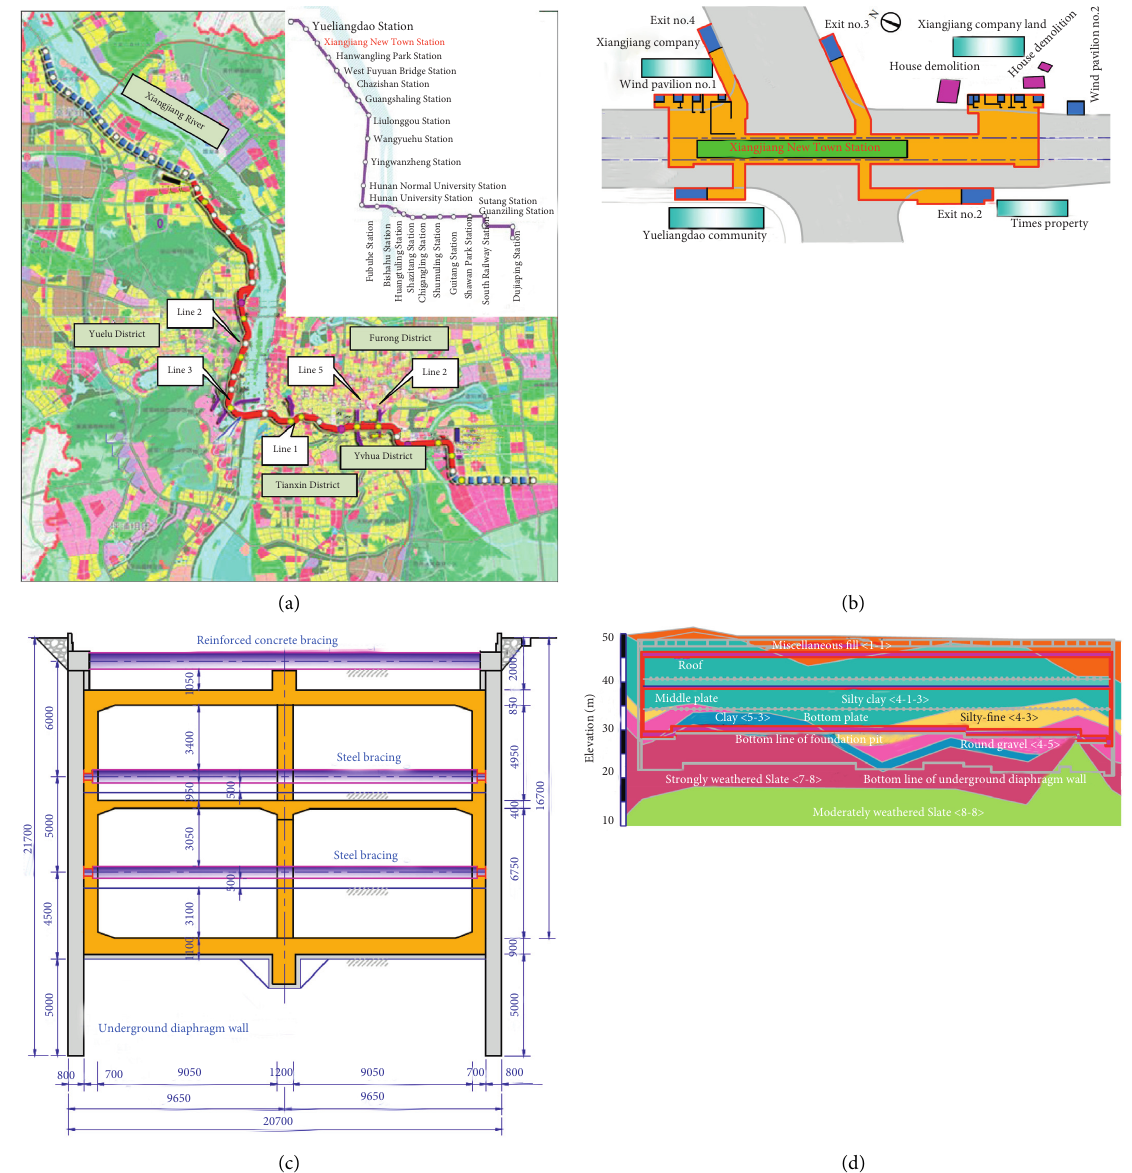
Figure 5: Diagram of Xiangjiang New Town Station Site and Design. (a) Location of station. (b) Plane. (c) Structure of station. (d) Geological